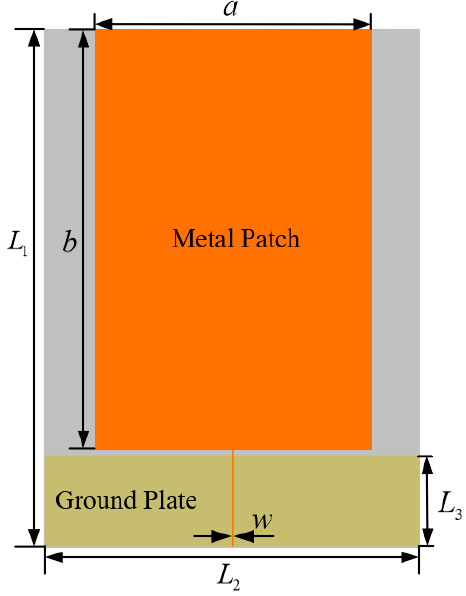
Figure 3. Unimproved monopole antenna.